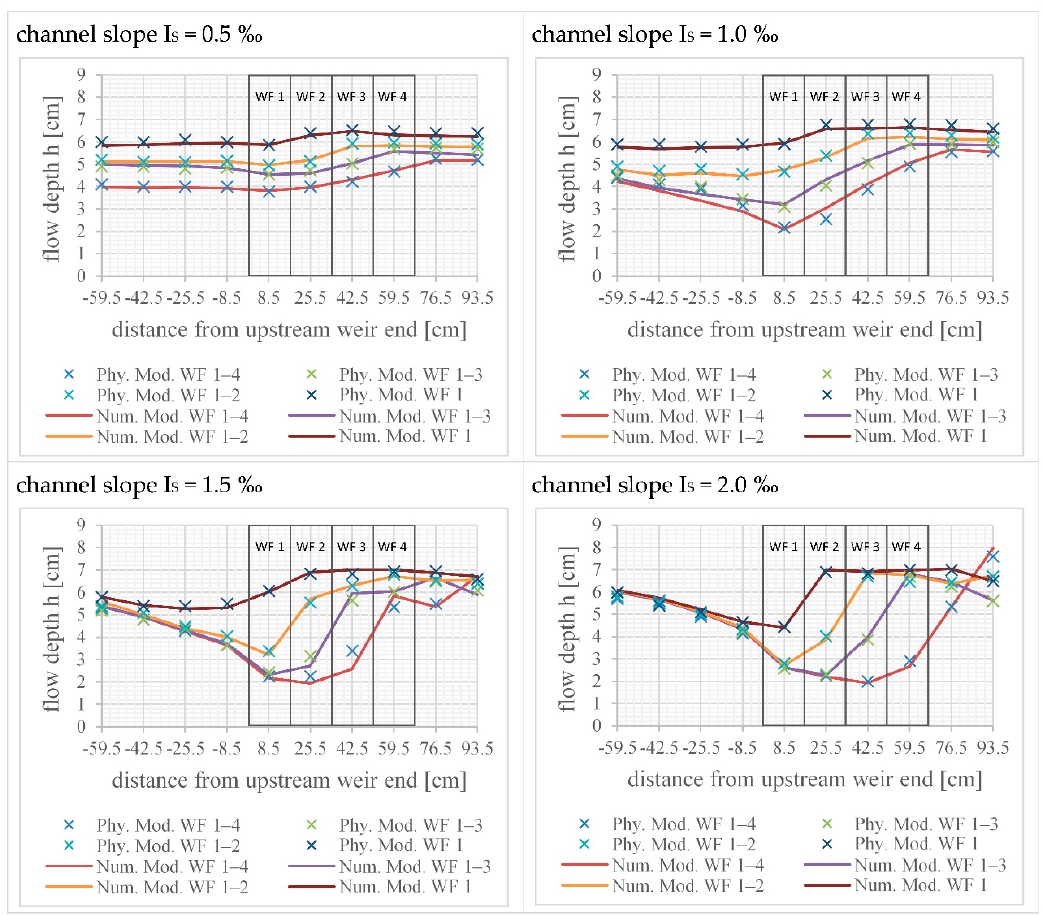
Figure 8. Profiles of the flow depths h above the weir crest determined in the numerical and in the physical model along the weir depending on the number of weir fields opened for channel slopes of 0.5–2.0‰ (including position of weir fields 1–4); flow direction from left to